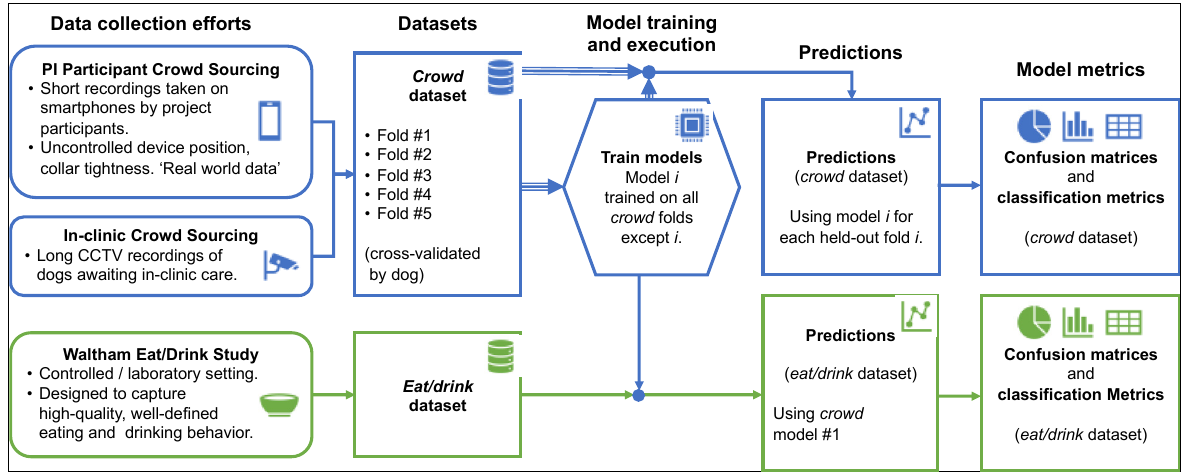
Figure 3. Model training and evaluation data flow. The crowd dataset consisted of naturalistic, highly diverse data divided by dog into five folds. The eat/drink dataset focused on high-quality eating and drinking data. Behavior classification models were trained and evaluated in a cross-validated fashion (where a given model i is trained on all folds of data except fold i) on the crowd dataset, and the first of these five models was also evaluated on the eat/drink dataset. Confusion matrices and classification metrics were produced for each dataset using the resulting